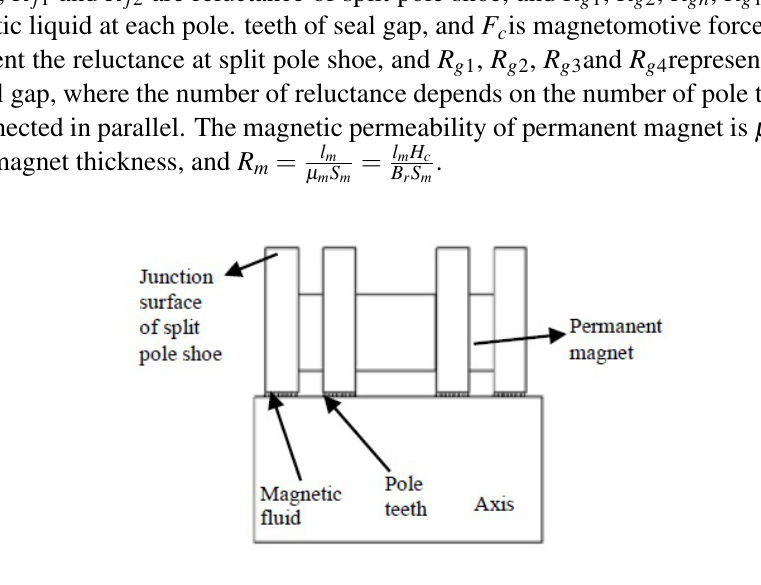
Fig. 2 Axial sectional drawing of seal structure.